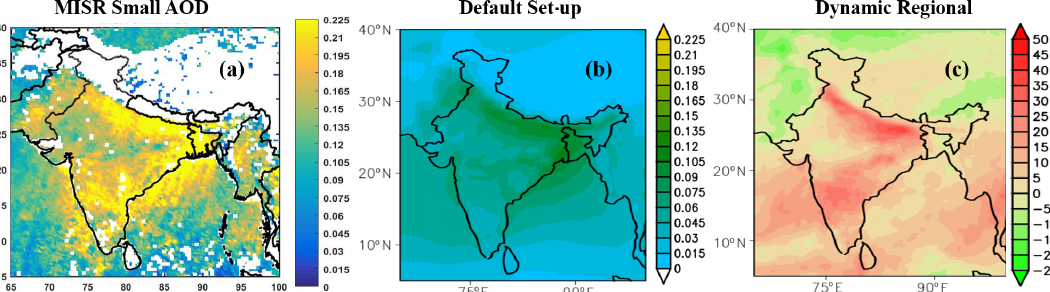
Figure 7. Spatial distribution of (a) MISR small-mode AOD (white colour implies no data), (b) AAOD simulated by Default_Sc, and (c) the percentage increase in AAOD simulated by the augmented model with respect to Default_Sc for 2010.